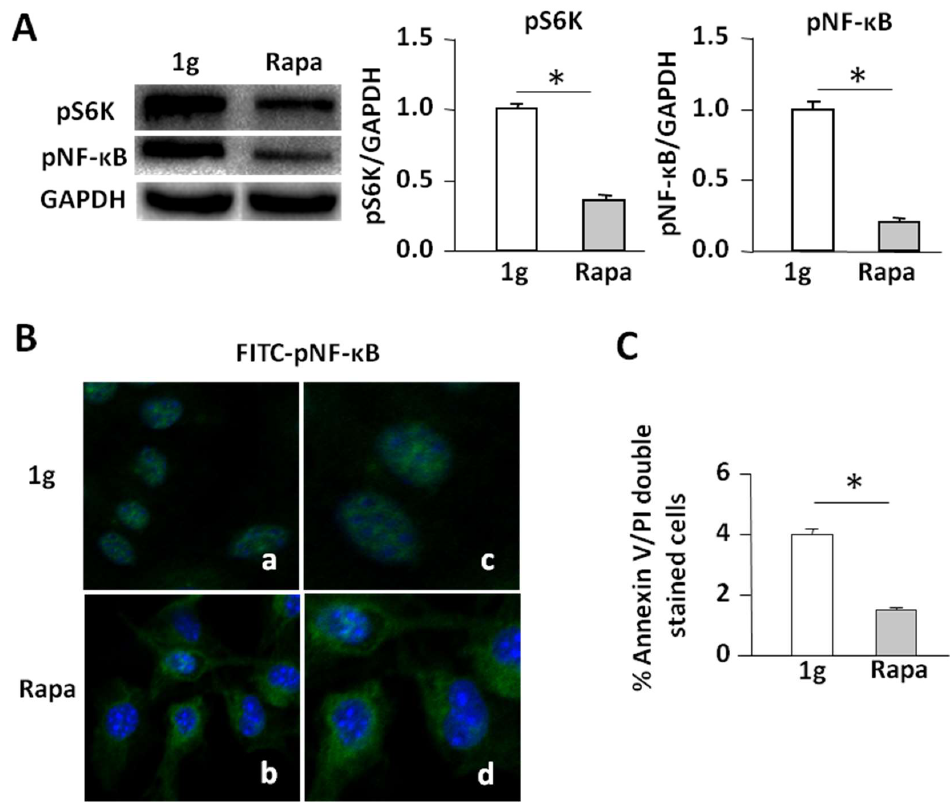
Figure 5. Rapamycin inhibits the mTORC1/NF-κB pathway resulting in the enhancement of apoptosis in cells under the 1 g condition. ( A ) Western blotting analysis. Lysates were harvested from BL6-10 cells cultured for three days under 1 g or 1 g +rapamycin and subjected to SDS-PAGE analysis. Proteins were transferred onto PVDF membranes. Blots were stained with various antibodies and analyzed by chemiluminescence. Bands were qualified using Imaging Lab software (Bio-Rad). Densitometric values were normalized to the GAPDH control. Data represent the mean ± SD of three independent experiments; ( B ) Confocal microscopy analyses. BL6-10 cells cultured for two days under 1 g or 1 g +rapamycin were observed by confocal microscopy. Panels ( a , b ) using 20× magnification; panels ( c , d ) using 50× magnification. One representative experiment of three is shown; ( C ) BL6-10 tumor cells cultured under ground conditions (1 g) and SMG (µg) for 24 h were stained with Annexin V-FITC and propidium iodide (PI), and then analyzed by flow cytometry. Data represent the mean ± SD of three independent experiments. * p < 0.05 versus different groups.